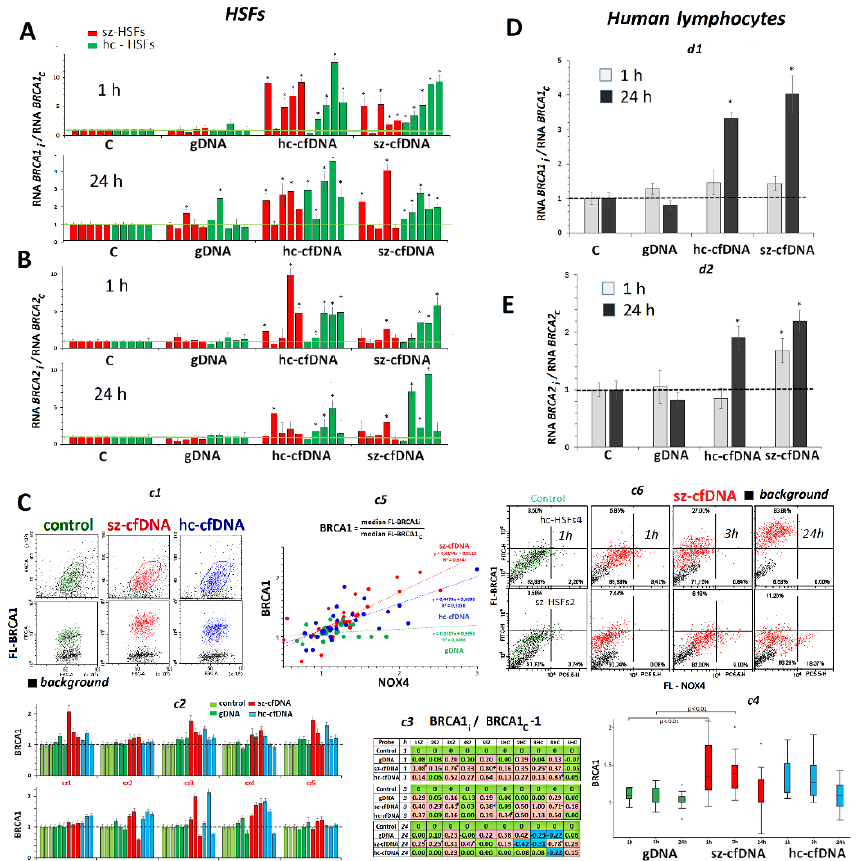
Figure 7. The influence of the DNA samples (50 ng/mL) on the expression of BRCA1 and BRCA2 genes in HSFs and PBL. ( A , B ). Change of the RNA BRCA1 and RNA BRCA2 levels. Average values for three measurements and standard deviation are given. The cultivation time and the DNA samples are indicated on the graph. (*) The response to cfDNA differs from the control HSFs ( p < 0.01). ( C ). c1 —The most typical examples (for sz-HSF1,1h) of the BRCA1 assay with FCA in HSFs. c2 —Index BRCA1: the values of the ratio m(FL-BRCA1)i/m(FL-BRCA1c). Average values for three measurements and standard deviation are given. c3 —Analysis of relative changes in BRCA1 levels in the presence of DNA samples compared to control. c4 —Changes in the BRCA1 levels in sample of HSFs (n = 10). c5 —Dependence of NOX4 index on BRCA1 index. c6 —sz-HSF2 and hc-HSFs4 staining with two types of antibodies with different labels: NOX4 (PC5.5) and BRCA1 (FITC). ( D , E ). Change of the RNA BRCA1 and RNA BRCA2 in the PBL in the presence of DNA samples. Average values for four lymphocyte samples and standard deviation are given.